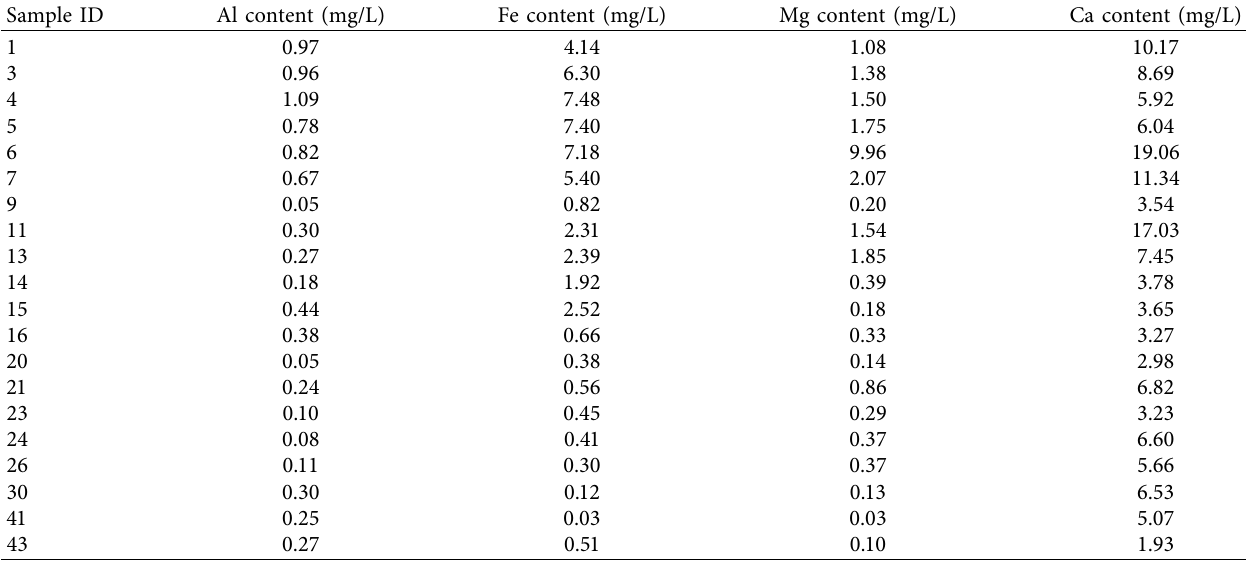
Table 4: The total metal concentration of Al, Fe, Mg, and Ca in selected water samples. Sample